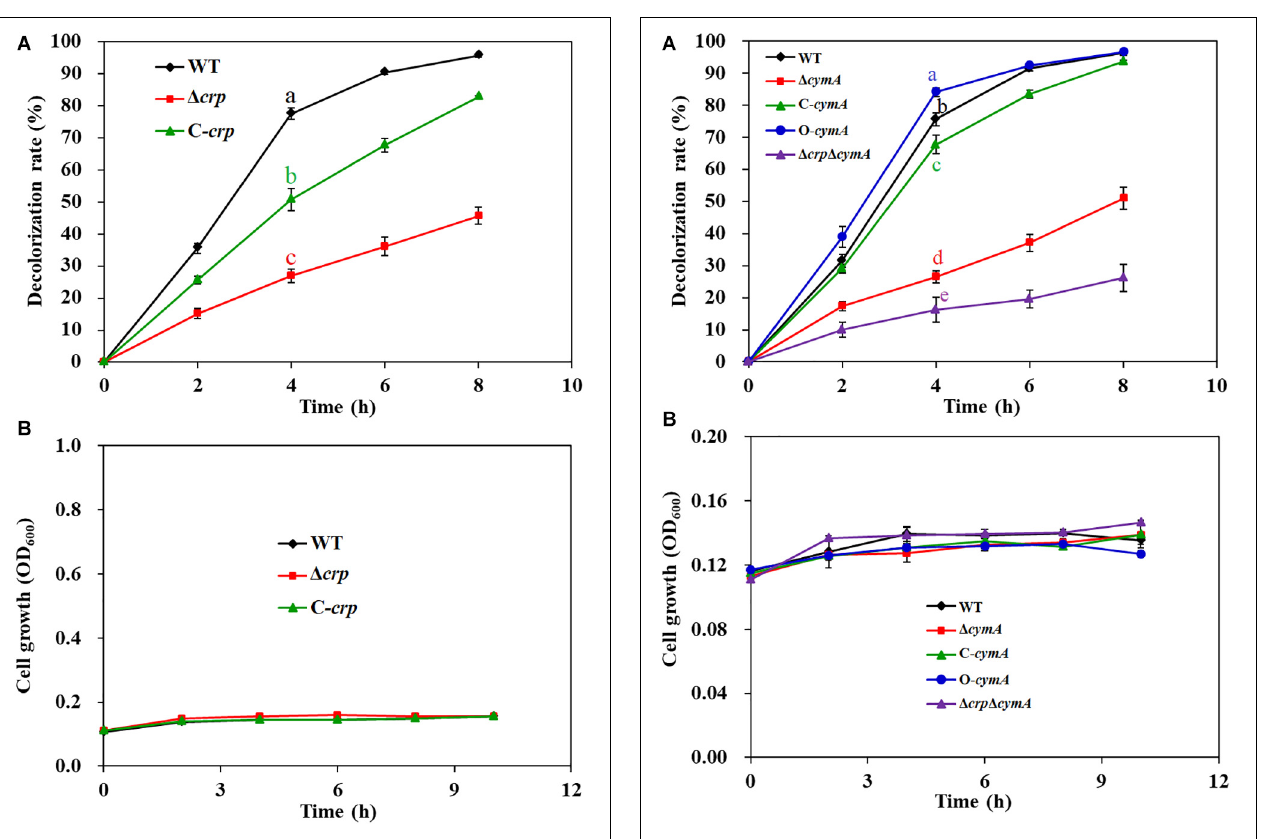
FIGURE 3 | Decolorization of AY (A) and cell growth (B) of the WT, (cid:49) crp mutant, and C- crp mutant. The initial concentration of AY is 200 mg/L. The cell growth was determined in the decolorization medium under anaerobic conditions. Values for decolorization and cell growth are means ± SD ( n = 3). Significance analysis of decolorization rates of different strains at 4 h was performed using one-way analysis of variance (ANOVA) with the Tukey–Kramer comparison test ( p < 0.05).